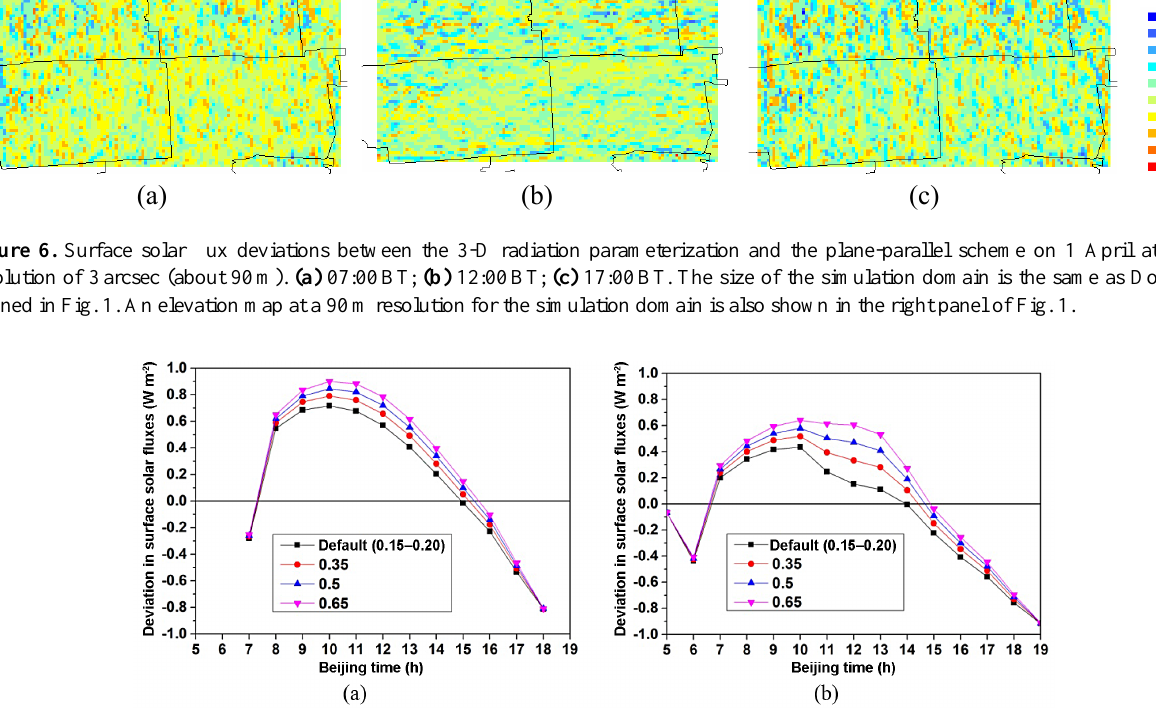
Figure 7. Sensitivity of surface solar flux deviations between the 3-D radiation parameterization and the plane-parallel scheme to the surface albedo in a typical urban area in Domain 1 (defined as rectangle B in Fig. 1) on (a) 1 April, (b) 1